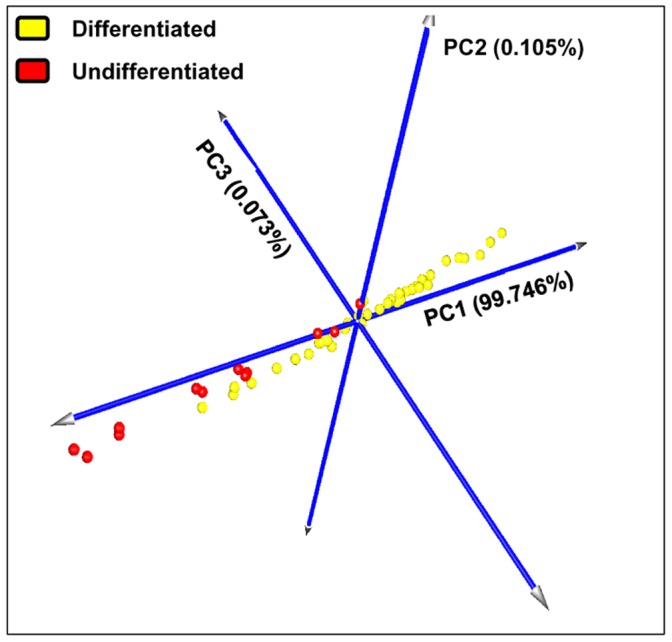
Principal component analysis of array-processed samples using marker gene data.Each colored sphere corresponds to an individual sample classified by PAM analysis (differentiated mast cell tumors are indicated in yellow, while undifferentiated ones in red). The value of each principal component is reported on the graph. The sum of the three principal components accounted to the 99.924% of the total variance.